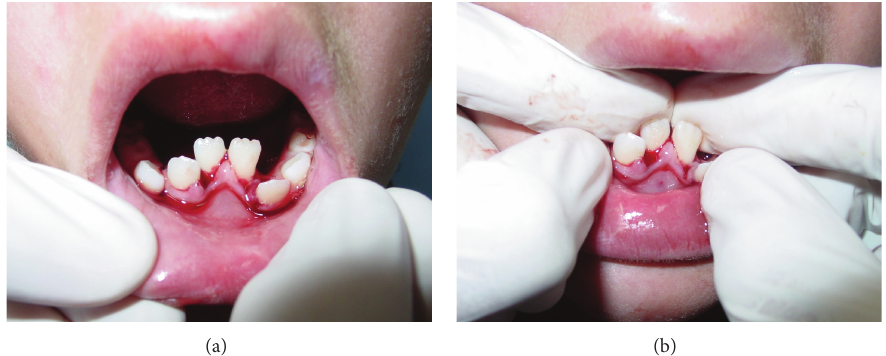
Figure 3: (a) Initial intraoral view. (b) Bone fracture reduction by digital pressure.